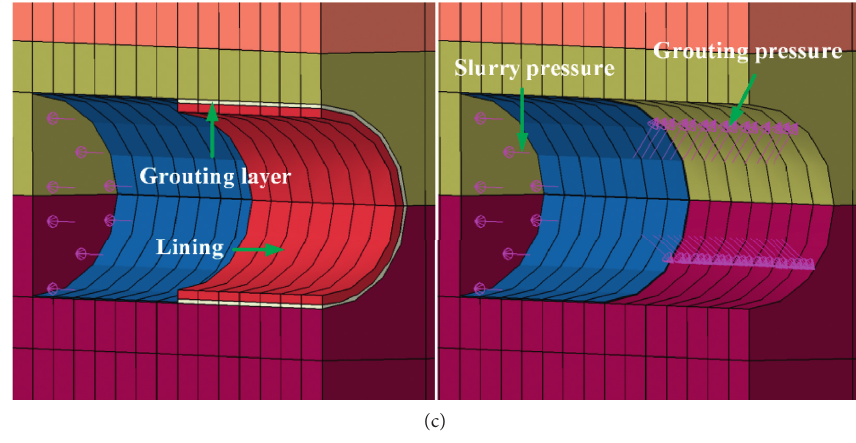
Figure 8: Illustration of the excavation simulation in FEA.